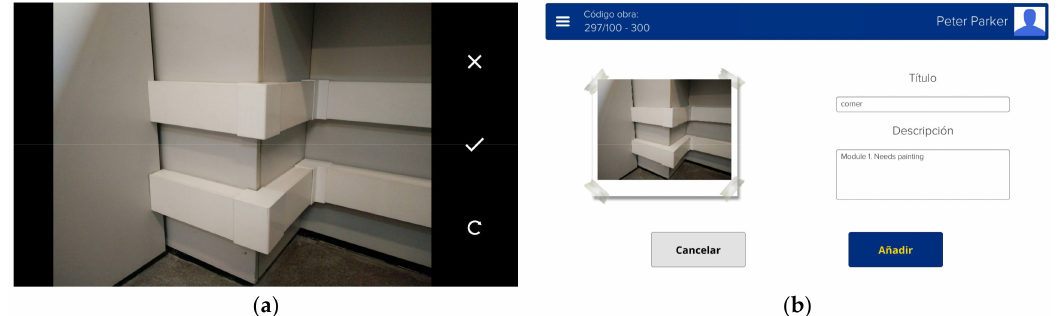
Figure 5. Image acquisition: ( a ) a captured image, with accept/cancel/rotate buttons; and ( b ) a captured image with related information, written by the inspector during the process; the add button adds the image and the comments to the